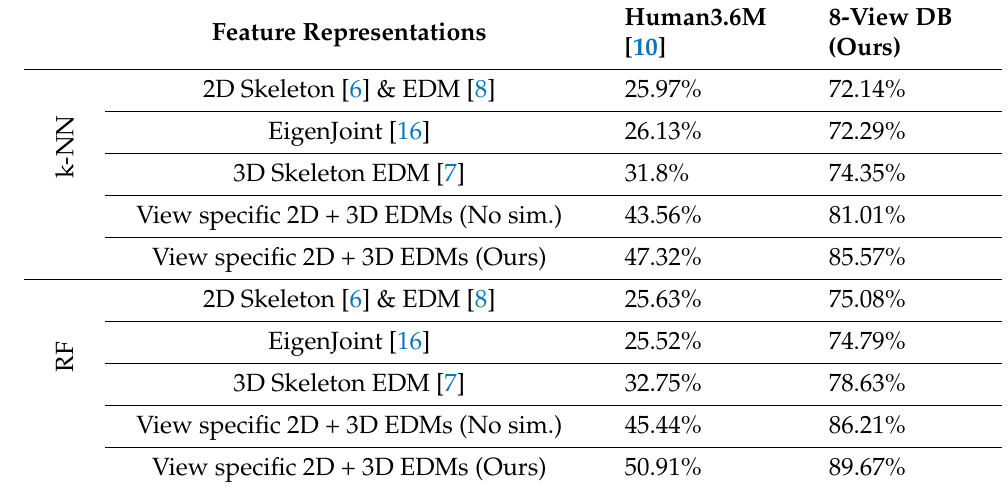
Table 1. Quantitative comparisons.